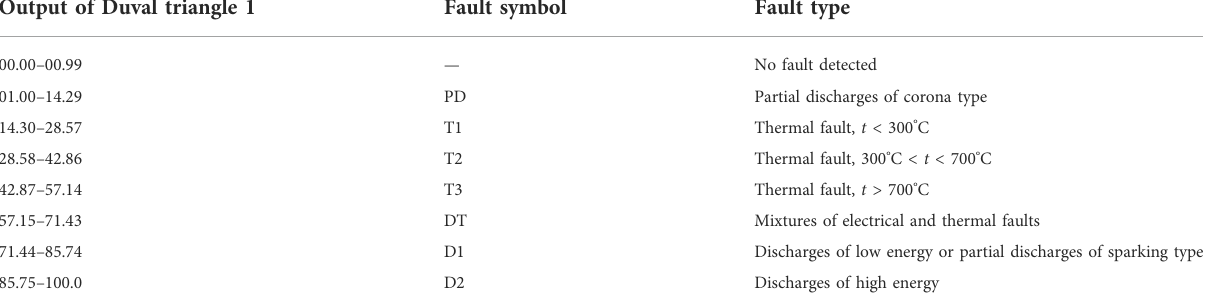
TABLE 3 Fault identi fi cation based on Duval triangle